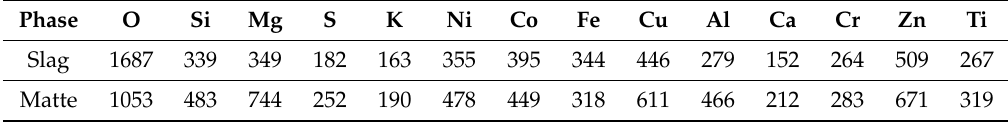
Table 4. Electron Probe X-ray Microanalysis (EPMA) detection limits in